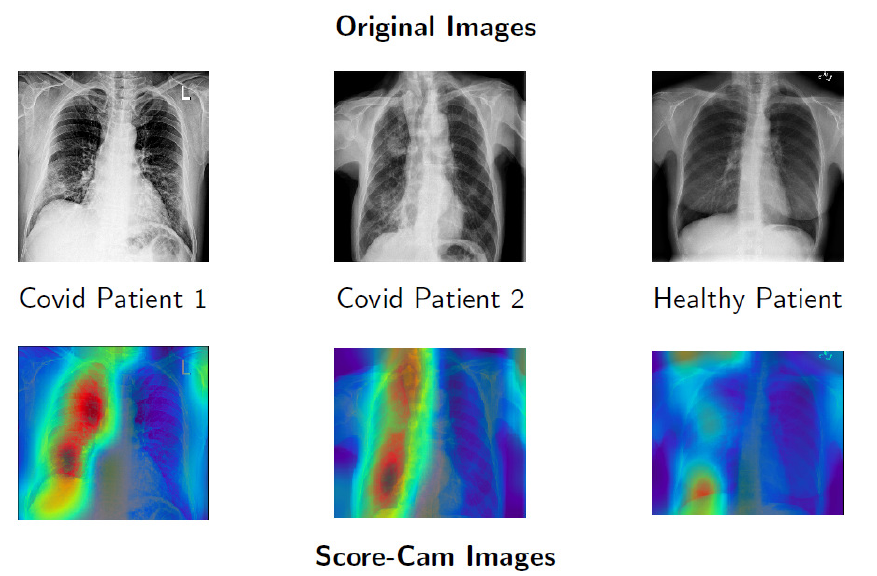
Figure 7. Score-CAM on various X-rays. X-rays from